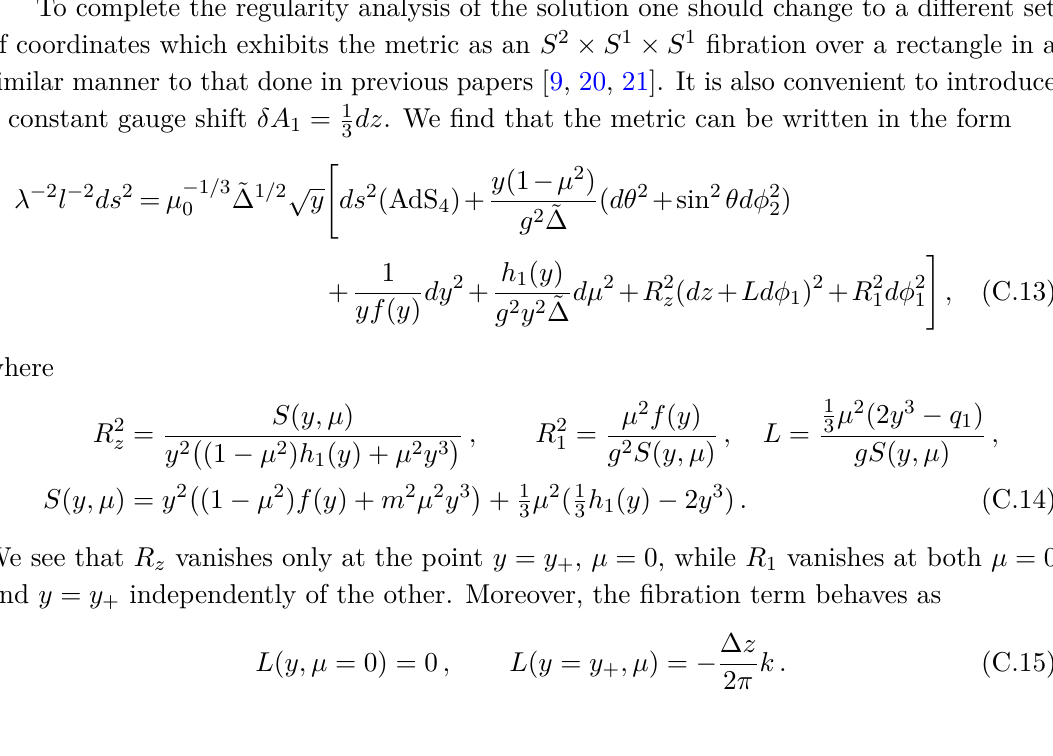
Figure 2 . A schematic plot of the rectangle over which the S 2 × S 1 the interior of the rectangle all the fibers remain of finite size. Along the boundary various cycles shrink. The red dot on the bottom right hand corner is the location of a monopole of charge k